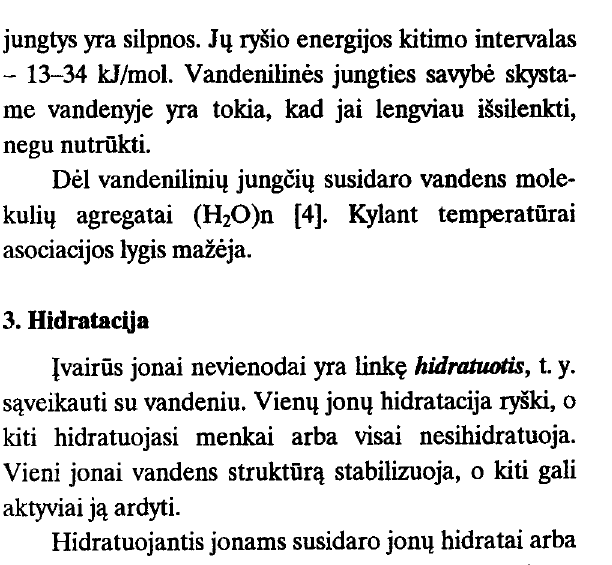
Scheragll) Fig 2. Schematic clustered model of water in liquid state, ie mixture of separate molecules and networked structure (according to Nemethy and Sheraga)